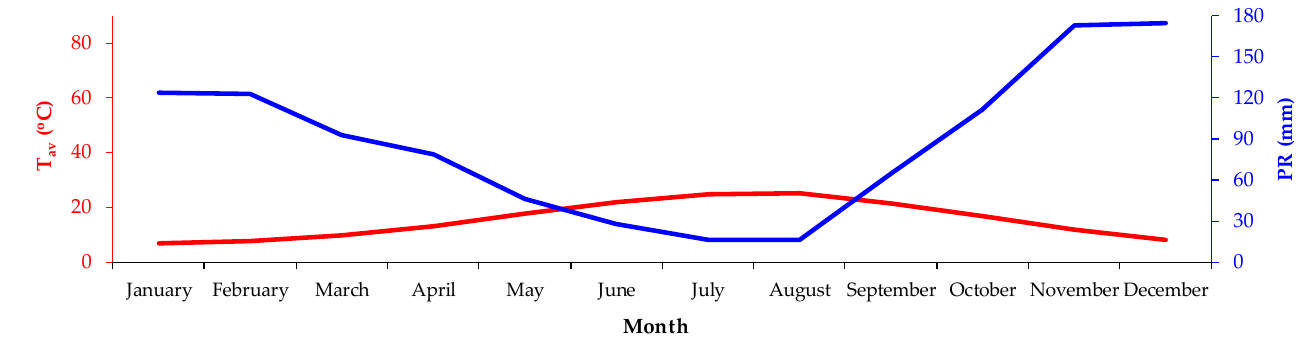
Figure 2. The pluviothermic diagram of the 1973–2020 period indicating air temperature T av (left axis) and bulk precipitation PR (right axis) average monthly values.